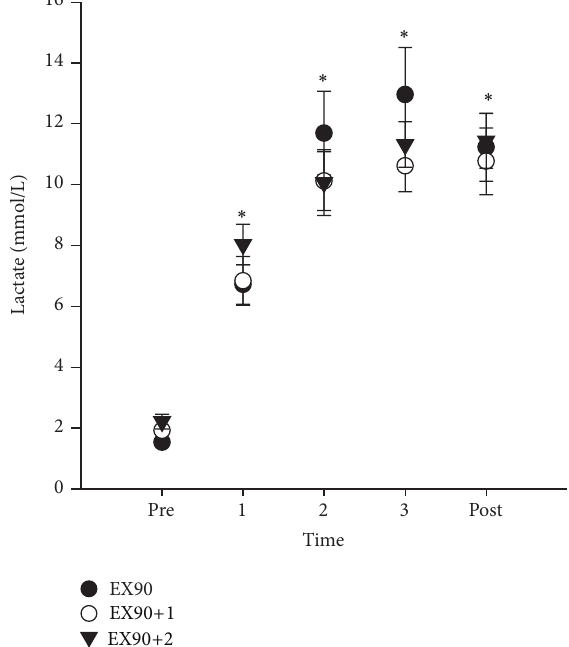
Figure 4: Mean blood lactate levels (mmol/L) for the three high intensity exercise groups ( ± SE) at time points before exercise (pre), intervals 1, 2, and 3, and 5min after exercise (post). ∗ Significant difference compared to pre values ( 𝑝 < 0.05